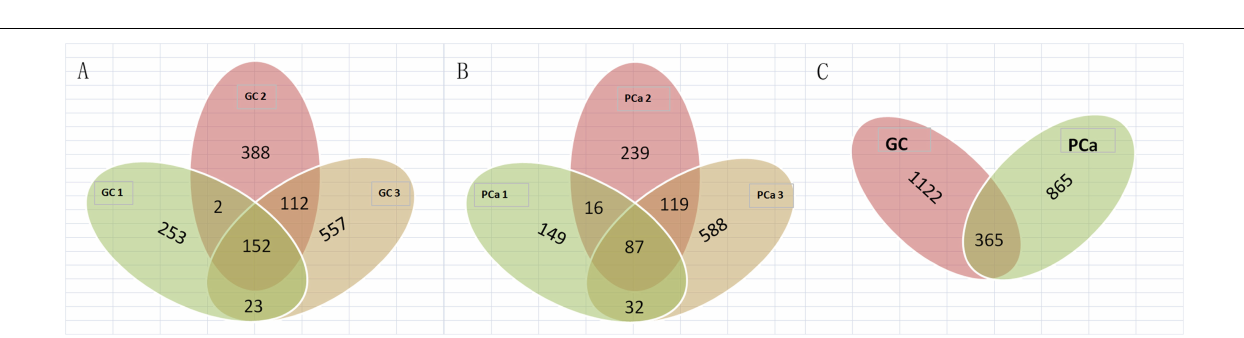
FIGURE 1 | Distribution of m6A peaks along transcripts. (A) Each transcript is divided into three parts: 5’ untranslated regions (5’ UTRs), coding sequence (CDS), and 3 (cid:48) untranslated region (3 (cid:48) UTRs). (B) The m6A peak distribution within different gene contexts. (C) The m6A peak distribution along a metagene.